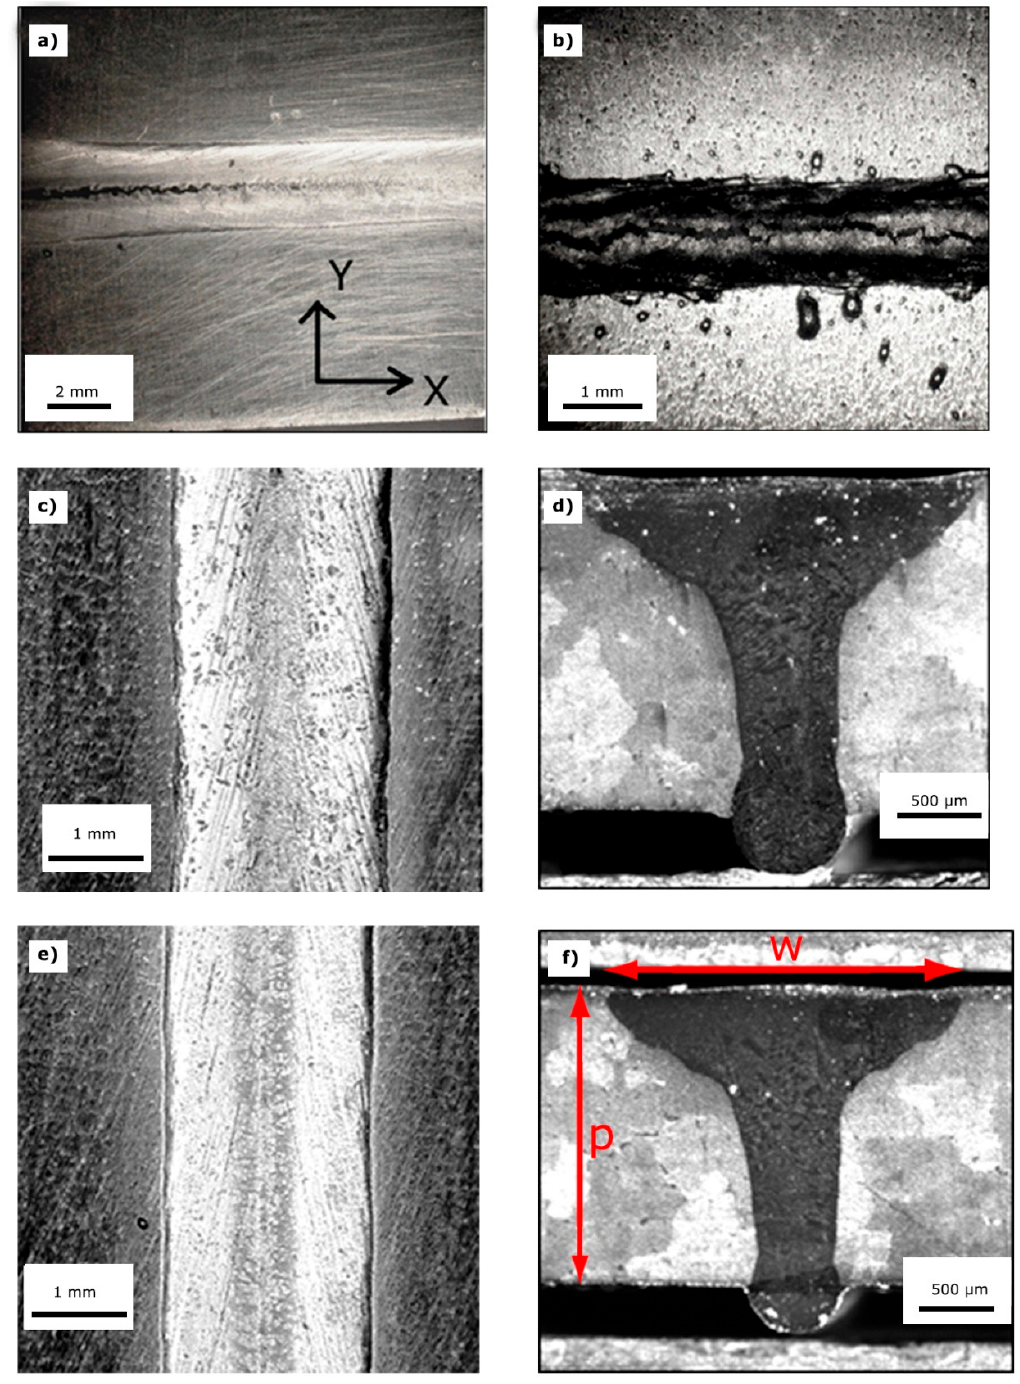
Figure 6. Seams of the samples EB welded with pre-heating (PHT) = 200 °C: pass speed of 1.0 m/min ( a , b ); 1.5 m/min ( c , d ) and 2.0 m/min ( e , f ); the image in ( b ) shows the opposite side of the seam in ( a ); cross-sections of the seams displayed in ( c , e ) are shown in ( d , f ); respectively; the parameters p and w are displayed in ( f ).